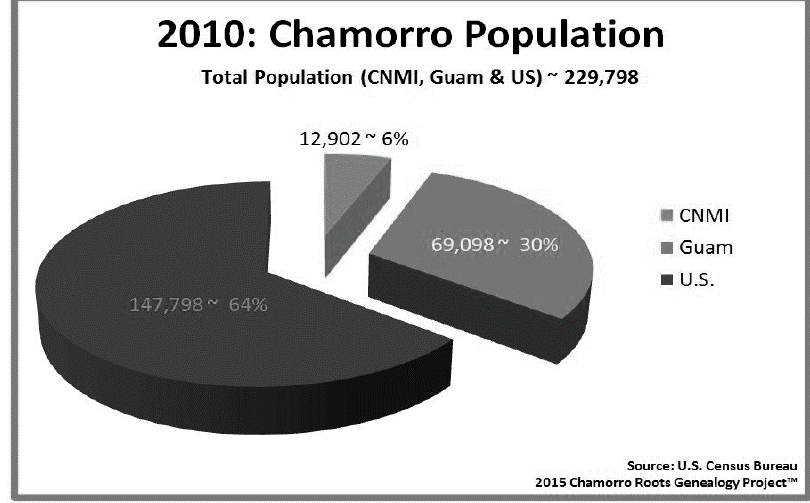
Figure 2. 2010 CHamoru Population (American FactFinder n.d.).